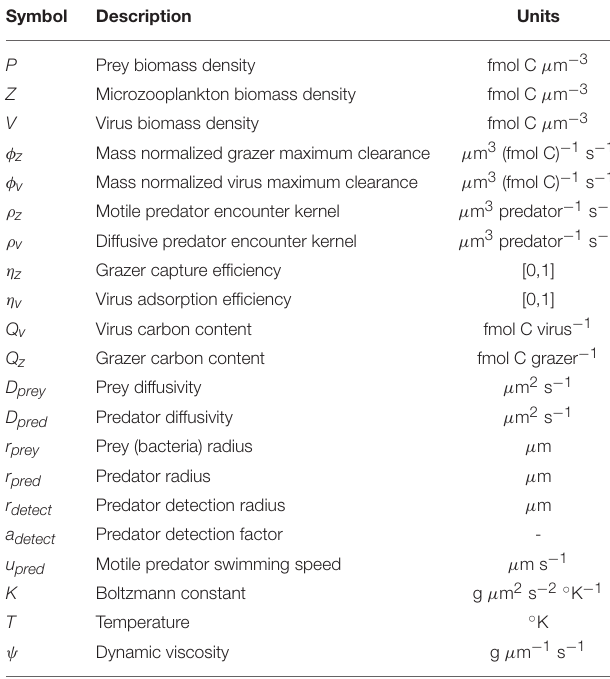
TABLE 1 | Model parameter and variable descriptions and